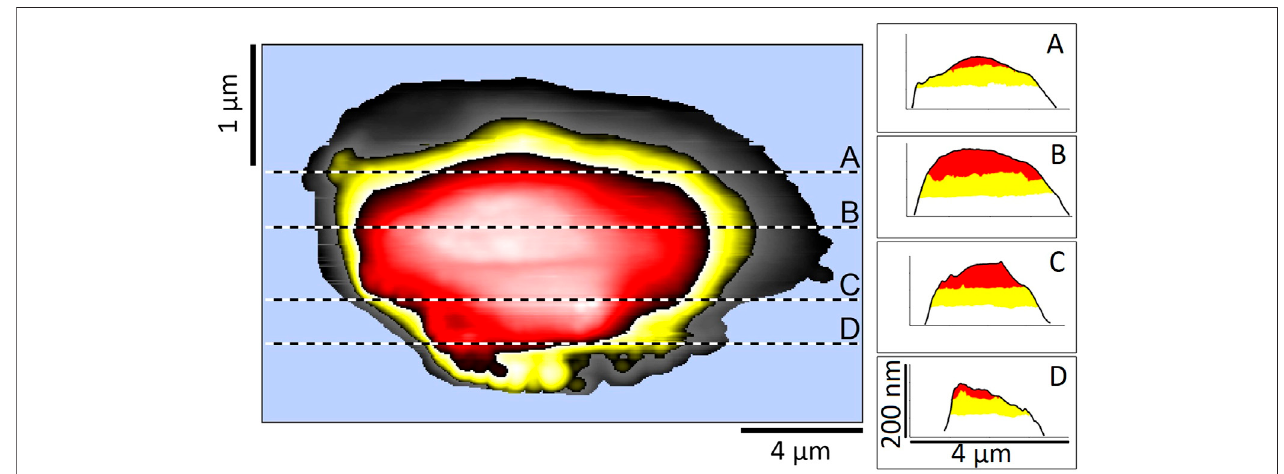
FIGURE13| Topography (left) andfourlinepro fi les[rightpanel, (A – D) ]oftestparticleNo.2beforetesting.Twovolumes,wornintwosuccessivetests,areplotted inredandyellowscalesfromblack(low)towhite(high).Blackandwhitedashedlinesinthetopographydenotethepositionsofthepro fi lelines.Inthefourlinepro fi leswith the same X - and Y -ranges, black lines correspond to the unworn particle; the red (yellow) areas mark the worn cross sections after the fi rst (second) test. The sliding direction coincides with the vertical axis of the topography.